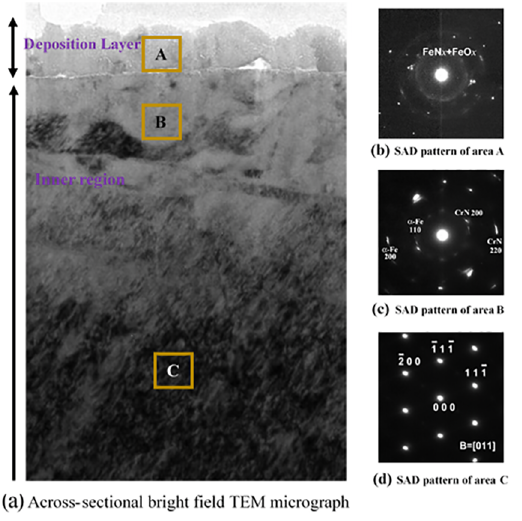
Figure 8 . Across-sectional bright field TEM micrograph and selected area electron diffraction (SAD) pattern from the near surface of the 440°C oxy-nitrided sample.